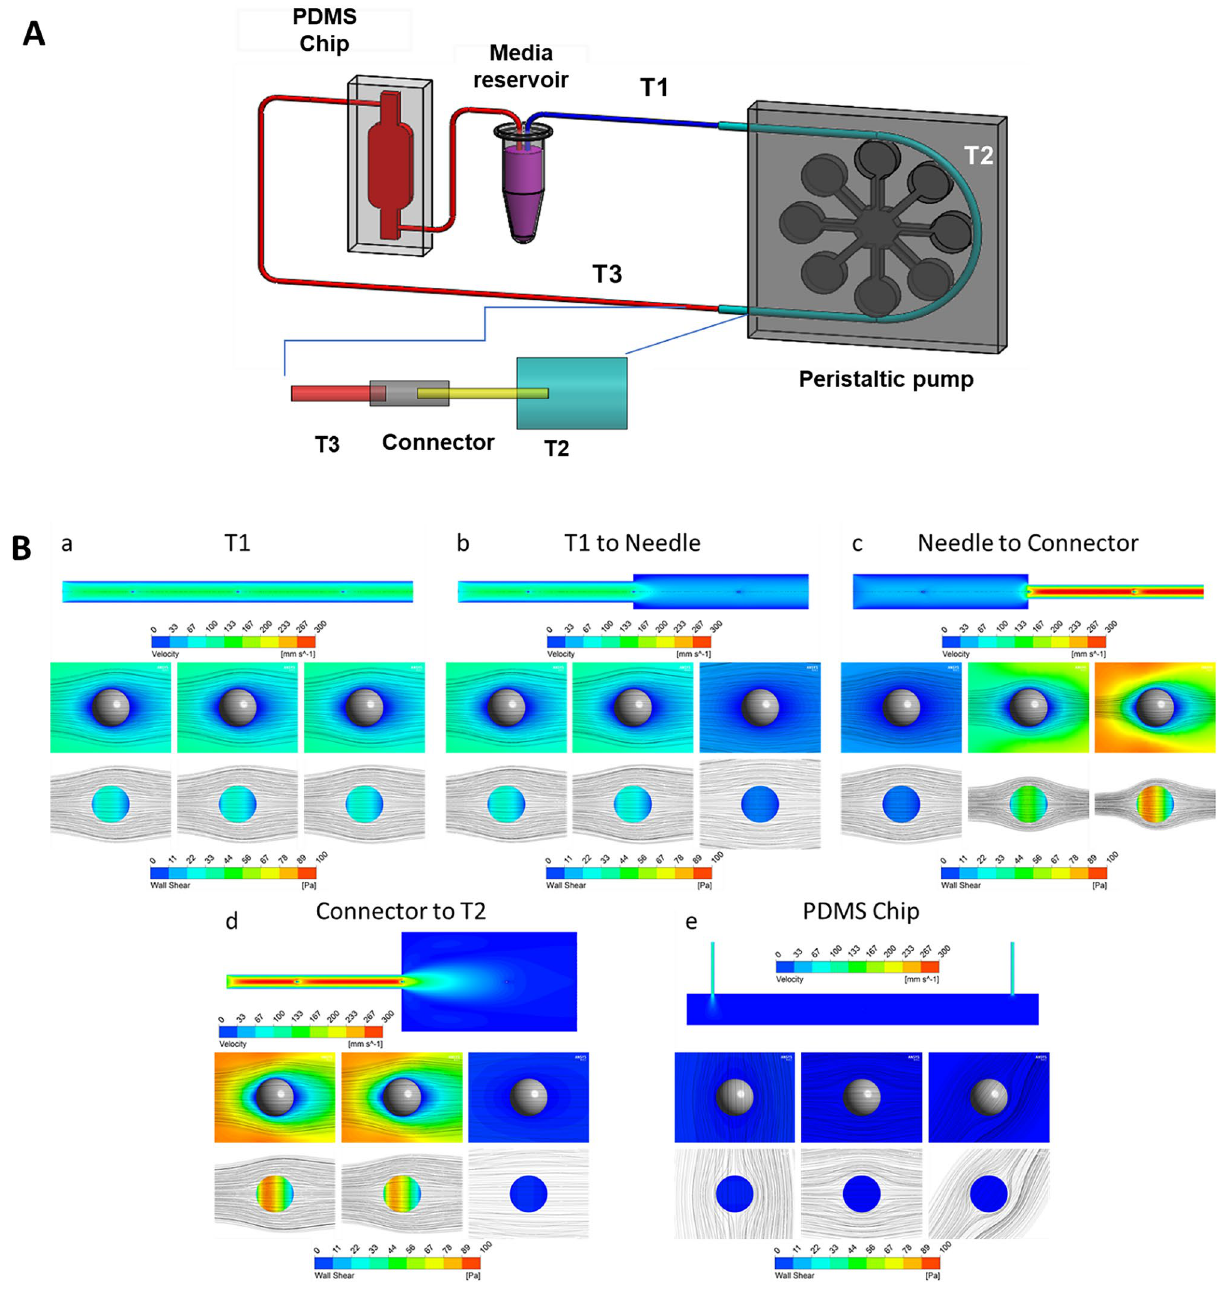
Figure 2. Variations in the internal diameter in the tubing system modifies the flow dynamics. Cancer cells can go from a static, attached state to being exposed to circulatory forces as they go from the primary tumor to their metastatic site. These different states can influence cancer cell viability and behavior. We designed a microfluidic system to recapitulate the circulatory system to simulate the drastic changes that occur in pressure and flow rate when cancer cells enter circulation. ( A) Representative illustration of the microfluidic system and a segment of the tubing system with different internal diameters. ( B) Simulation of flow dynamics changes due to changes in the tubing internal diameter. Flow streamlines and contours of circulatory shear stress on cancer cells that change in different segments of the system as measured by the Reynolds number (Re). ( a) First tubing segment T1 (ID 0.304 mm) from the cell culture media reservoir; ( b) Flow from T1 to T2 (ID 0.304 mm to ID 1.42 mm); ( c) Flow from T2 to connector (ID 1.42 mm to ID 0.2 mm); ( d) Flow from connector to T3 (ID 0.2 mm to ID 1.42 mm) ( e) Flow through T3 (ID 0.30 4 mm); ( f ) Flow from T3 to the PDMS chip (ID 0.5–25mm 3 ); ( g ) Flow through PDMS chip (25 mm 3